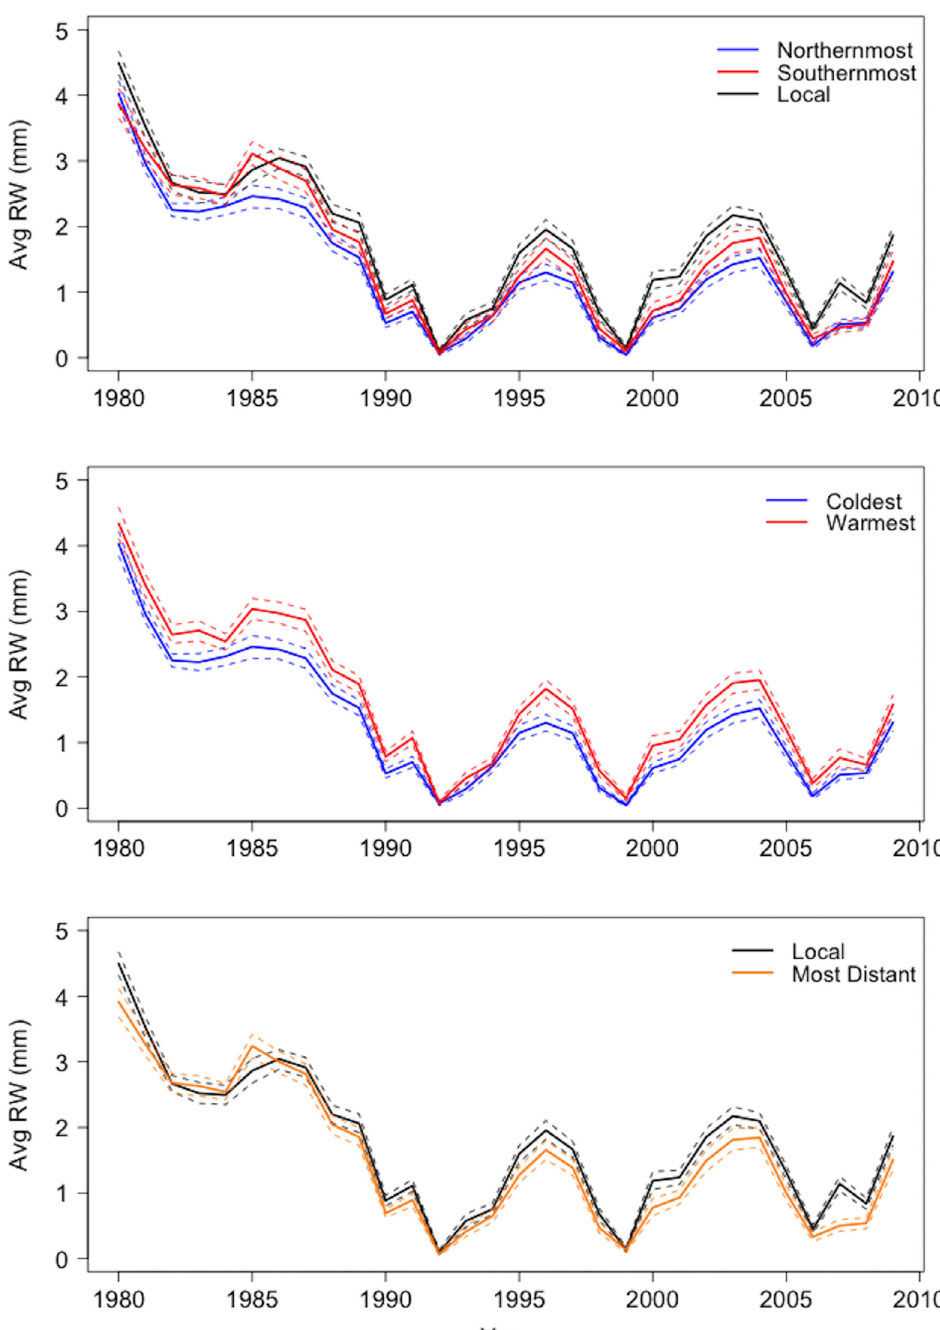
Fig 5. Seed source average growth through time. Average yearly tree-ring width and 95% bootstrap confidence intervals of trees from the five northernmost, southernmost, local, coldest, warmest, and most distant seed